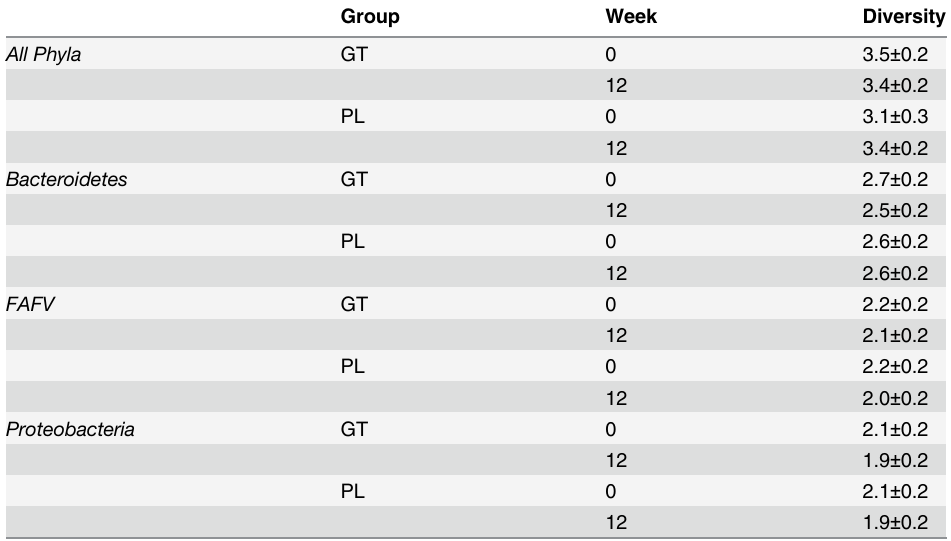
Table 3. Mean bacterial diversity per phylum in the green tea and placebo groups at baseline and week 12. Group Week Diversity All Phyla GT 0 3.5 ± 0.2 12 3.4 ± 0.2 PL 0 3.1 ± 0.3 3.4 ± 0.2 Bacteroidetes GT 0 2.7 ± 0.2 2.5 ± 0.2 PL FAFV PL Proteobacteria GT PL 1.9 ± 0.2 Green tea (GT, n = 30) and Placebo (PL, n = 28), FAFV: Firmicutes , Actinobacteria , Fusobacteria and Verrucomicrobia . Shannon diversity index, Values are means ± standard errors. Data were analyzed by a mixed ANOVA. No signi fi cant differences between groups (GT vs. PL), no changes over time (baseline vs. week 12) and no signi fi cant interactions were observed between treatment (green tea or placebo) and time (baseline and week 12) for all phyla combined, Bacteroidetes , FAFV and Proteobacteria . All relevant P- values are p >